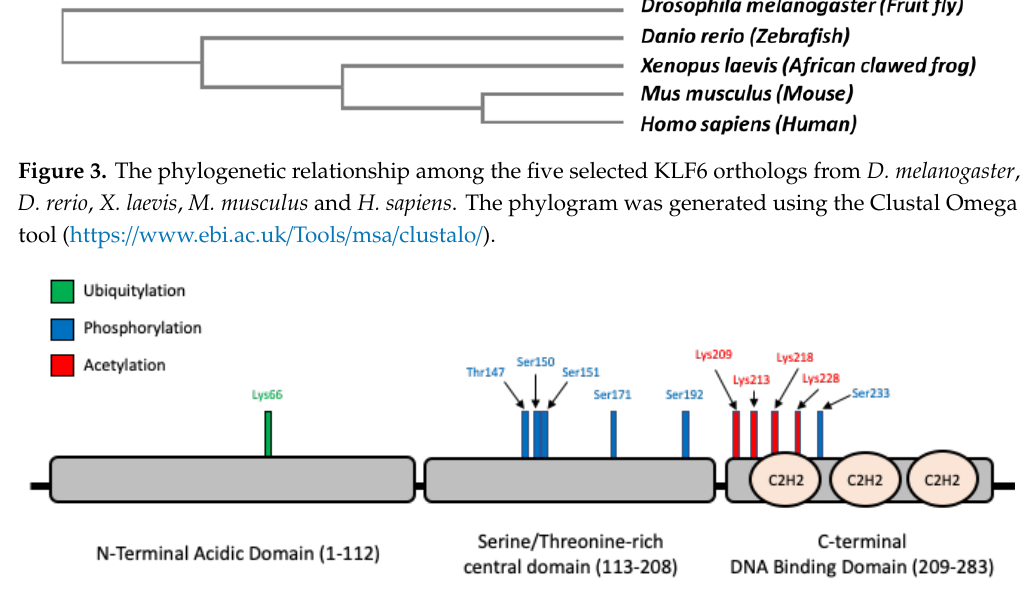
Figure 4. KLF6 protein structure and the associated post-translational modifications. The KLF6 protein consists of three domains: (I) N-terminal acidic domain, (II) serine/threonine-rich central domain and (III) C-terminal DNA-binding domain. The protein structure is adapted from Andreoli et al. [17]. According to PhosphositePlus (https://www.phosphosite.org/), the KLF6 protein undergoes three types of post-translational modifications (PTMs). The sole ubiquitylation site for KLF6 is located at Lys66-Ub. Phosphorylation is the best-documented KLF6 PTM, encompassing T147-p, S150-p, S151-p, S171-p, S192-p and S233-p. Finally, four lysine acetylation sites have been documented for the C-terminal, i.e., S209-Ac, S213-Ac, S218-Ac and S228-Ac.